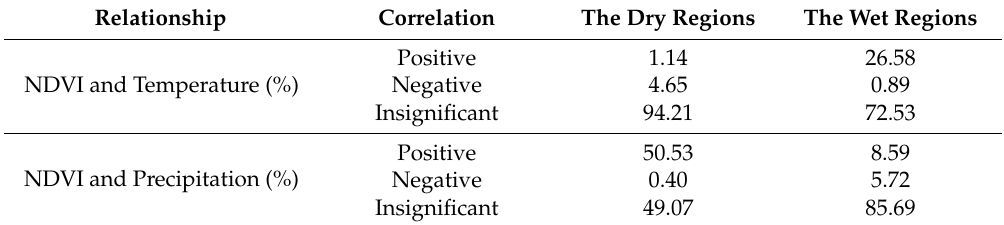
Table 2. Partial correlation coefficients for the relationships between the NDVI and temperature (upper) and between the NDVI and precipitation (lower) in different water conditions.